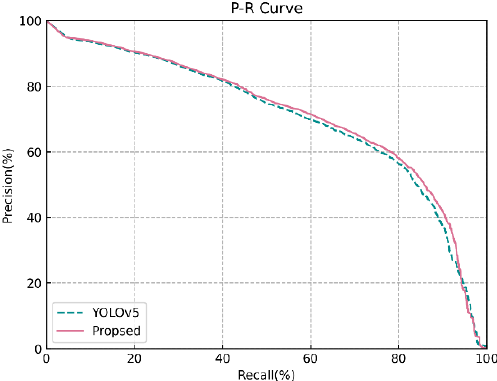
Figure 9. P-R Curve on the DOTA dataset.